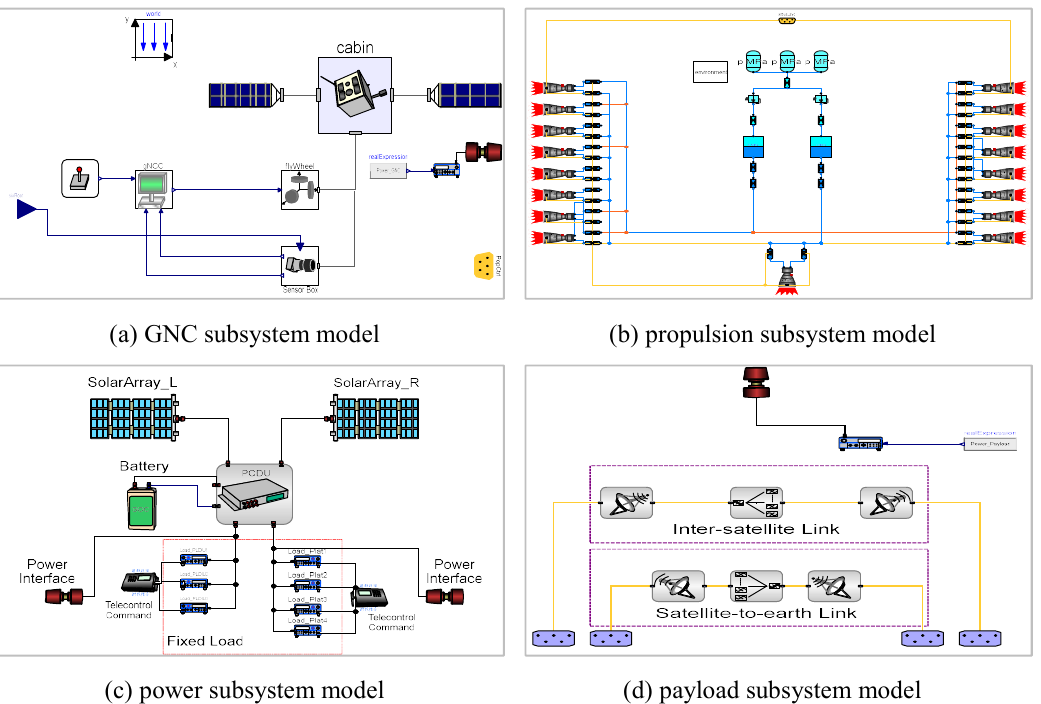
Figure 4. Four main subsystems that make up satellite model in